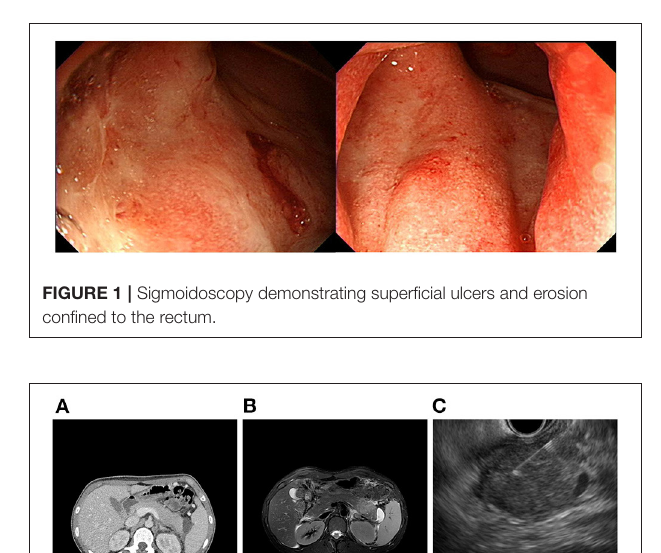
antibody, were all within the normal range. Sigmoidoscopy showed superficial ulcers and erosions confined to the rectum ( Figure 1 ). These findings were improved when compared revealed pancolitis. Abdominal computed tomography